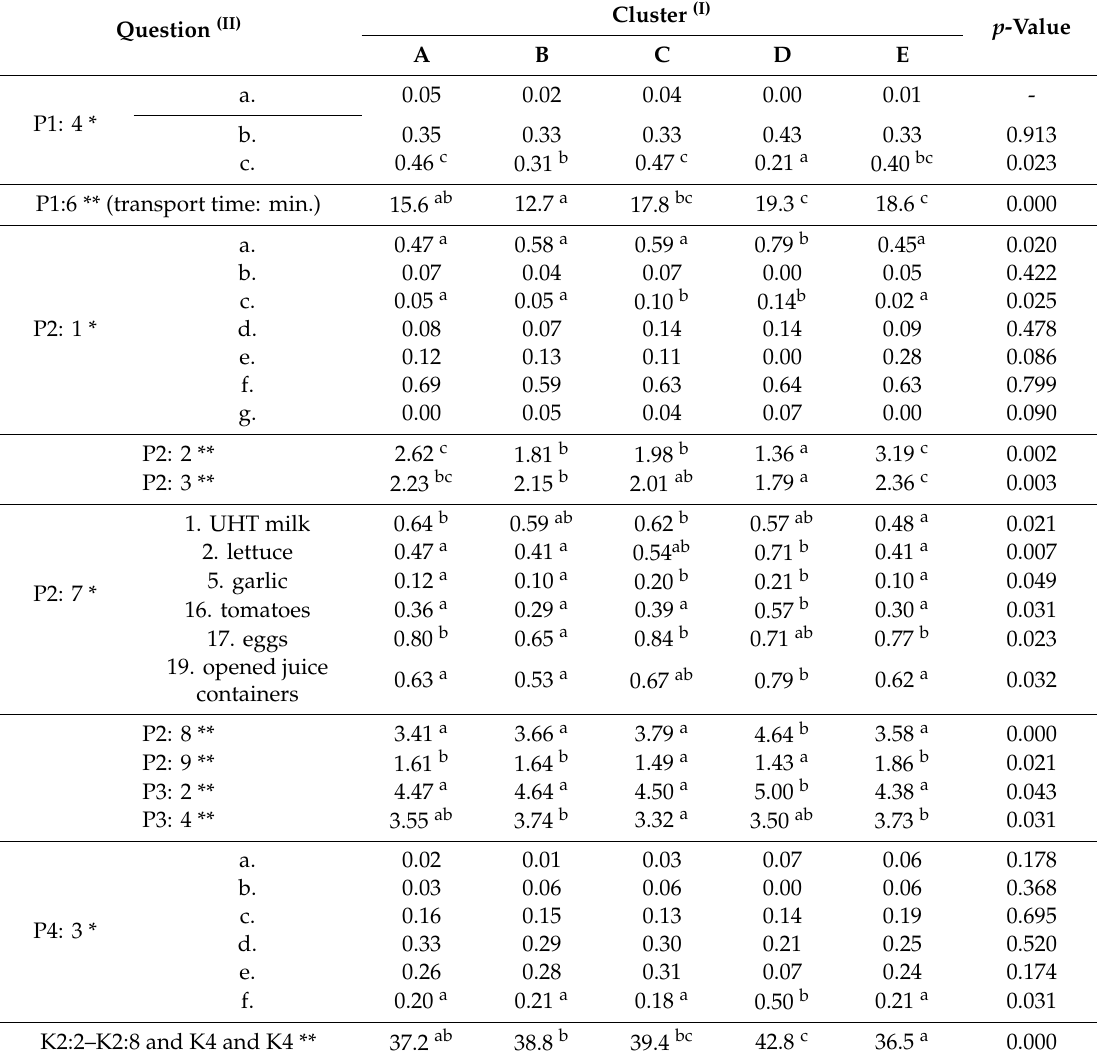
Table 5. Average level of frequency rate * or arithmetic mean ** for the identified clusters with the results of the variance analysis and the least significant di ff erence (LSD)